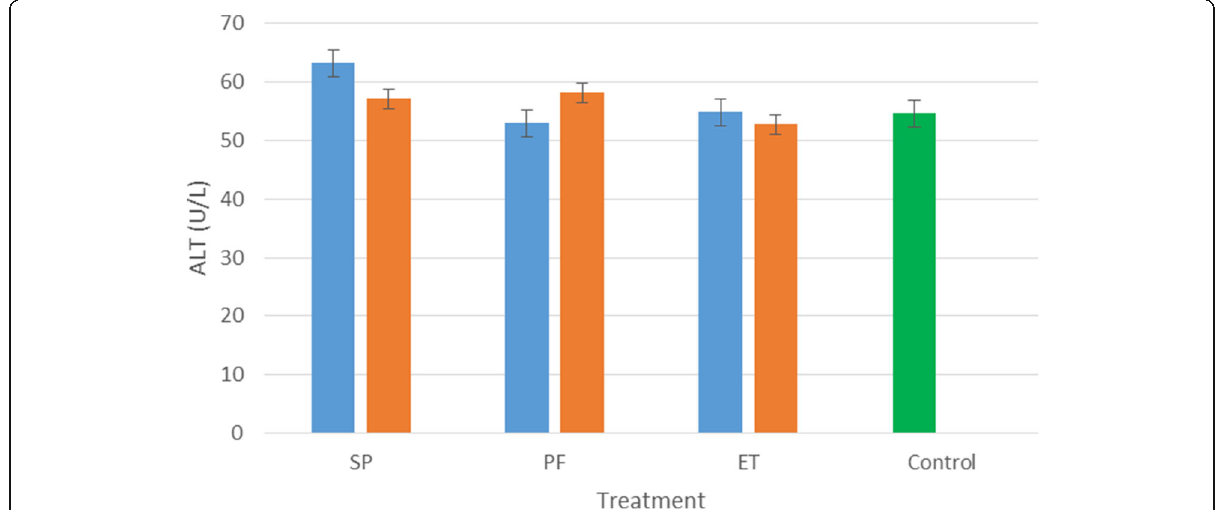
Fig. 1 Effect of the aqueous plant extracts on the levels of alanine aminotransferase in the